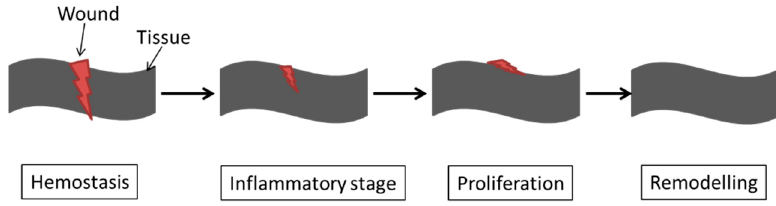
Figure 9. Schematic representation of the four stages involved in wound healing process .